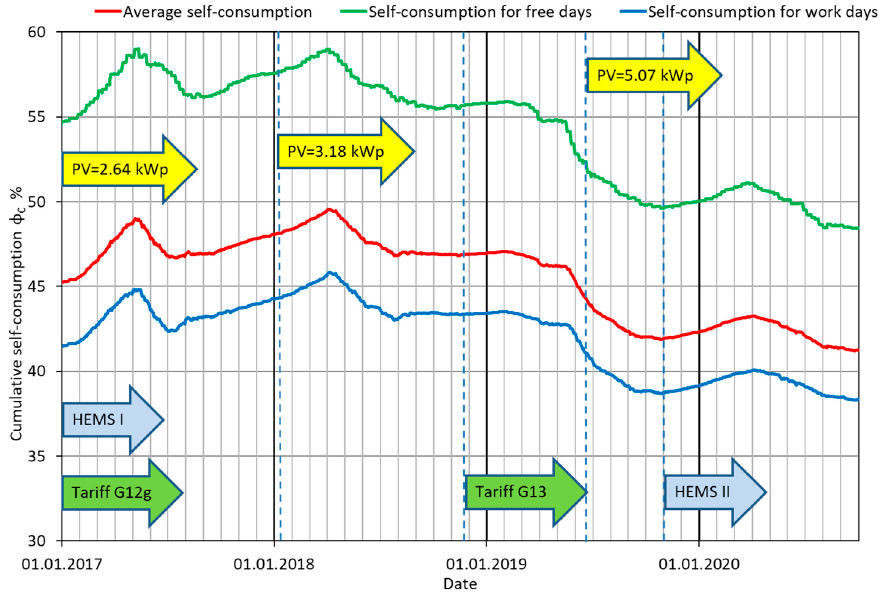
Figure 16. Cumulative self-consumption from the beginning of PVS’s existence.